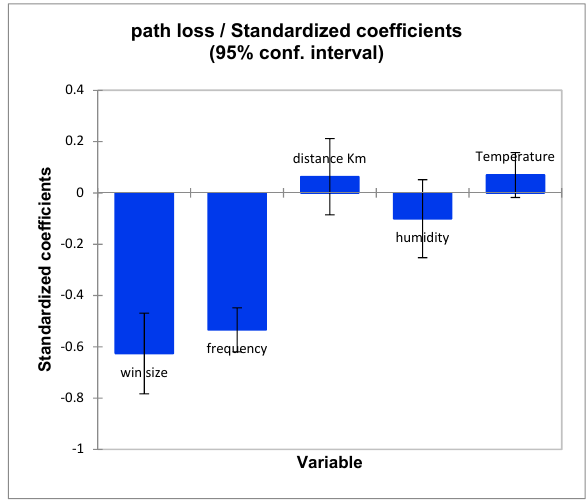
Figure 9. Standardized coefficients (96.7).